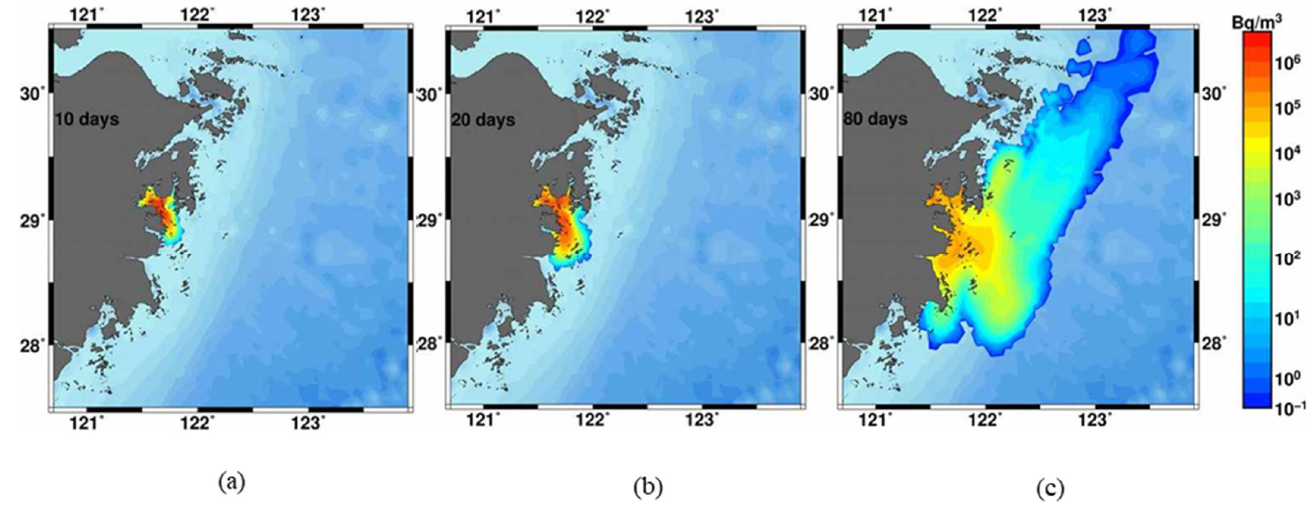
Figure 11. The surface concentration of 137 Cs after 10 days ( a ), 20 days ( b ), and 80 days ( c ) release from the Sanmen NPP.